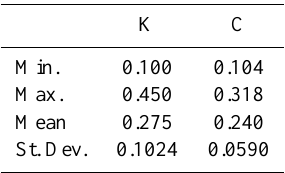
the Rambla del Poyo catchment.